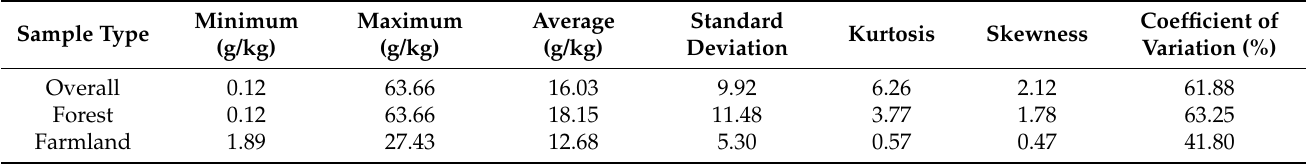
Table 4. SOC content statistics for farmland and forest.